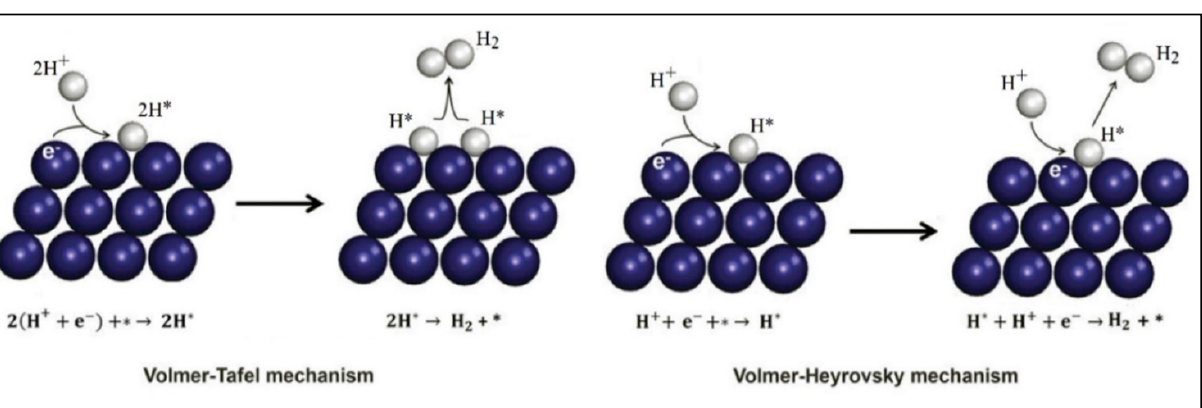
Figure 10. The possible mechanisms of HER on the catalyst surface in acidic solutions. The (*) refers to the active sites of the catalyst, H* refers to the adsorbed H • atom at the active site of the catalyst. Reprinted with permission from reference [198] .